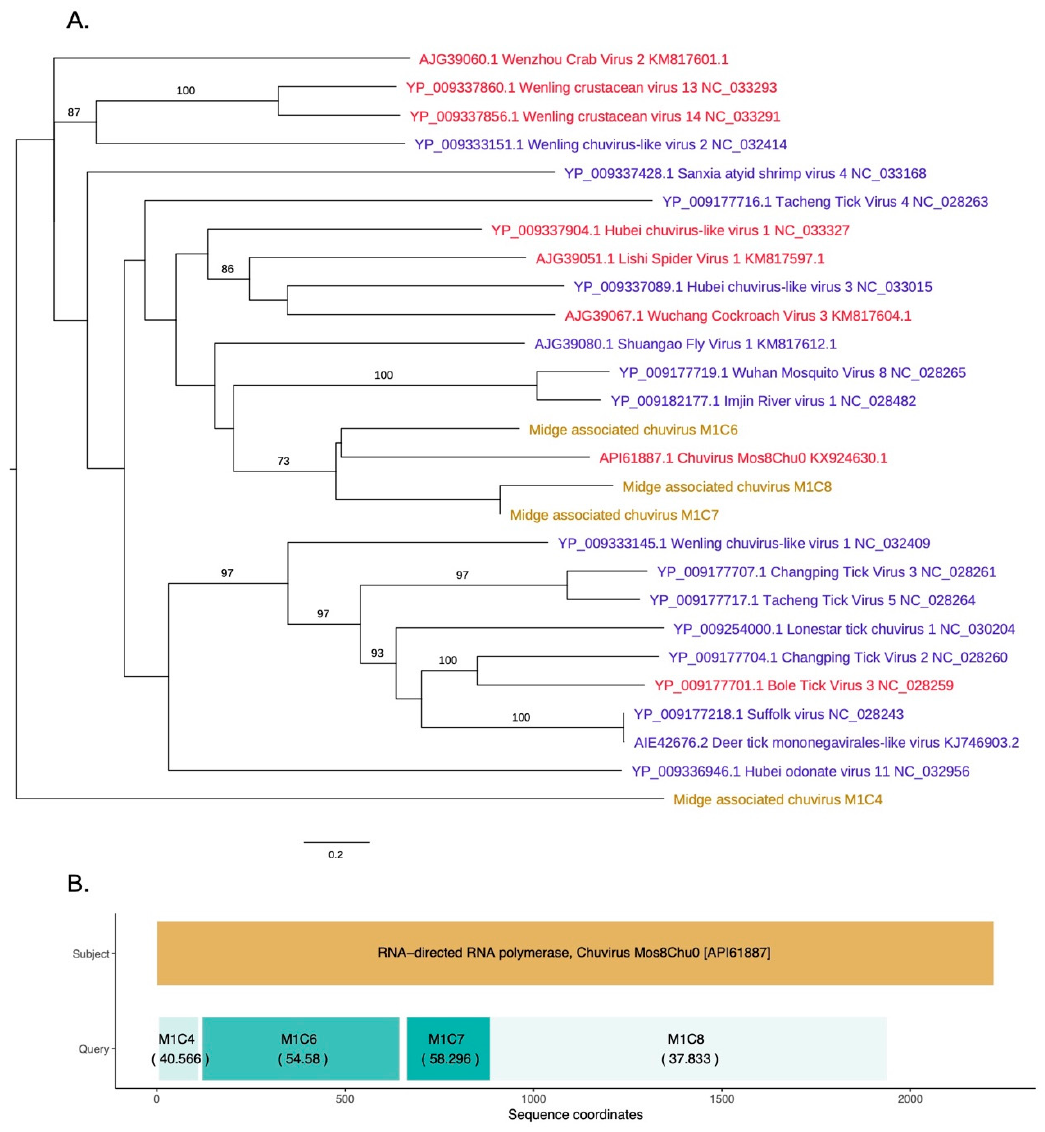
Figure 5. ( A ) RdRp based phylogeny describing clustering of a novel chuvirus species. Viruses that have two segments are highlighted with red tip labels. Blue tip labels highlight viruses that have one segment. Chuviruses found in the Scottish midge samples are highlighted in yellow. ( B ) Protein sequence similarity between Chuvirus Mos8Chu0 RdRp and midge chuvirus sequences with RdRp hits along with the sequence coordinates and coloured according to percentage identity.